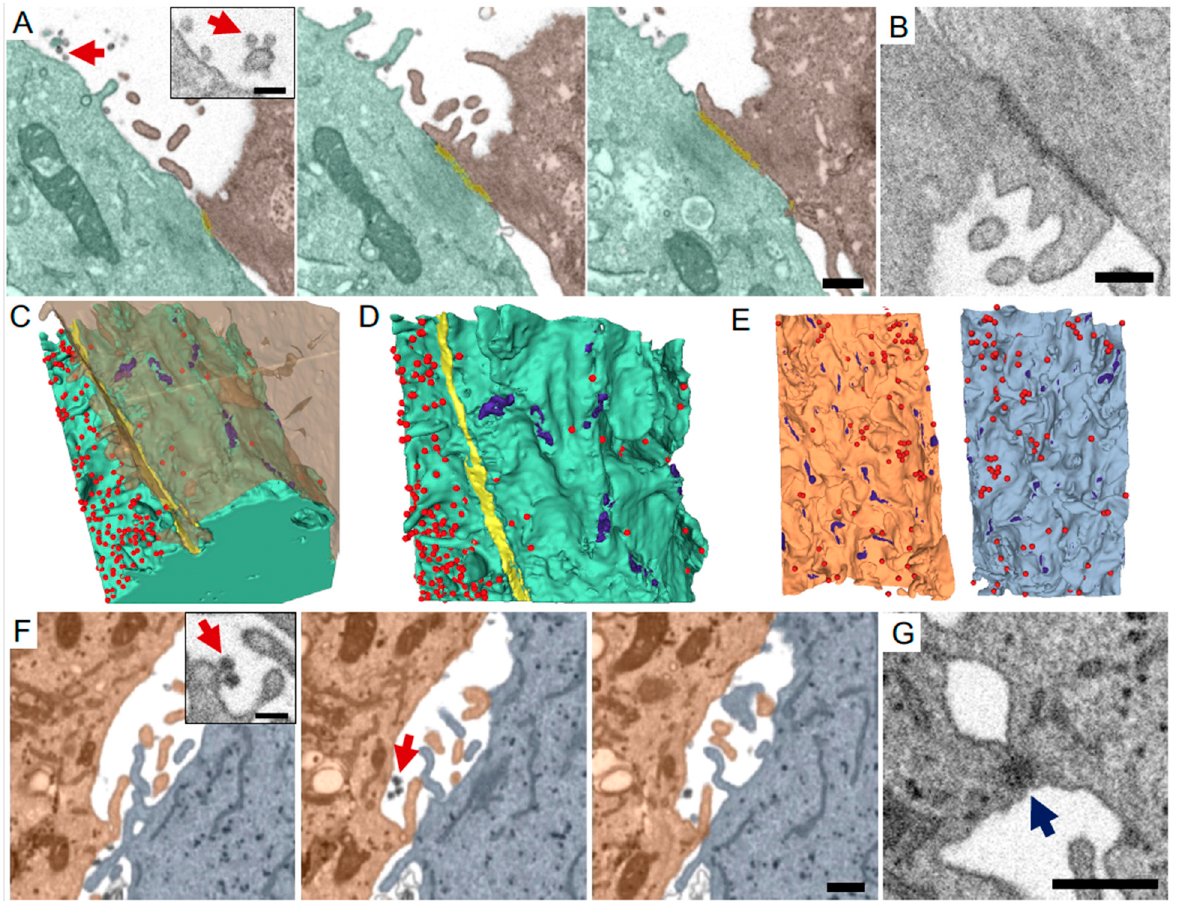
Figure 2. FIB-SEM imaging and 3-D reconstructions of SARS-CoV-2 viruses and cell-cell contacts. Infected Vero E6 cells ( A – D ) or Calu-3 human lung epithelial cells (Cortese et al., 2020) ( E – G ) processed for and imaged by FIB-SEM. ( A ) Periodic FIB-SEM micrographs of every 10th 8 nm slice showing a tight junction-mediated contact (yellow) between two Vero E6 cells (green and brown) and viruses in the extracellular space (red arrows). Inset shows high magnification view of viruses and cell membranes. ( B ) Higher magnification micrograph of a tight junction connecting the two cells in A. ( C , D ) 3-D reconstructions of plasma membranes of both cells in A ( C ). Virus particles appear as red spheres, small focal adhesions (likely desmosomes) are shown in purple, tight junction is shown in yellow. Viral density is dramatically different on either side of the contiguous tight junction ( D ). ( E ) 3-D reconstructions of two neighboring lung epithelial cells in contact (orange, light blue), separated to reveal the surfaces in closest proximity. Desmosome-like junctions were seen between the two cells (purple, and G ). Viral particles (red) are evenly distributed on the plasma membranes. ( F ) FIB-SEM micrographs of every 5th 8 nm slice from lung epithelial cells [15]. Same cells as in E. Red arrows mark viruses. ( G ) Higher magnification micrograph of a desmosome (blue arrow) between the two cells in E-F. Scale bars ( A , F , G ): 500 nm. ( A , F ) insets: 200 nm. ( B ): 300